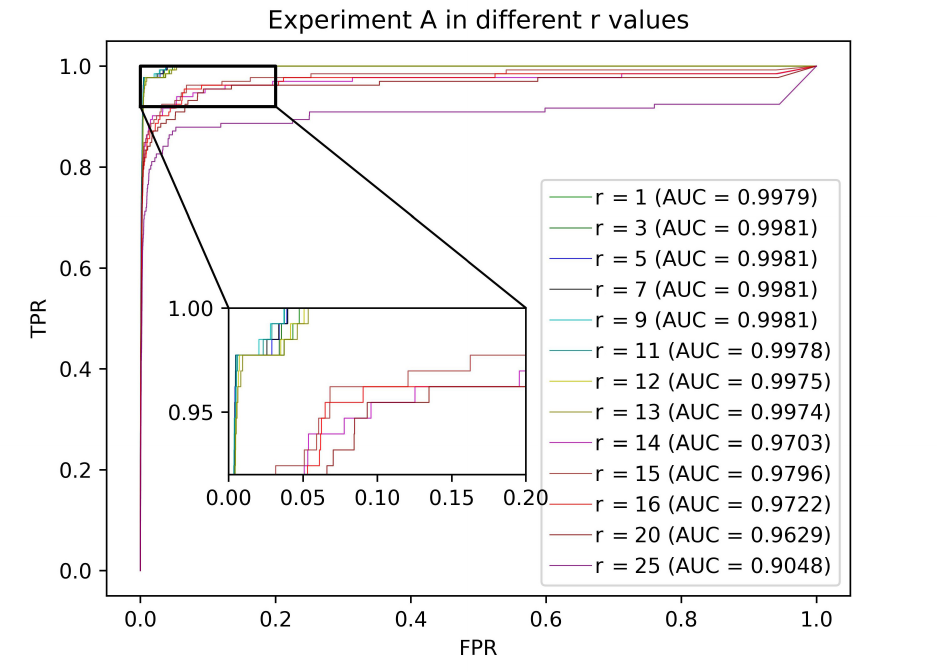
Figure 2. The influence of parameter r on the predictive performance of